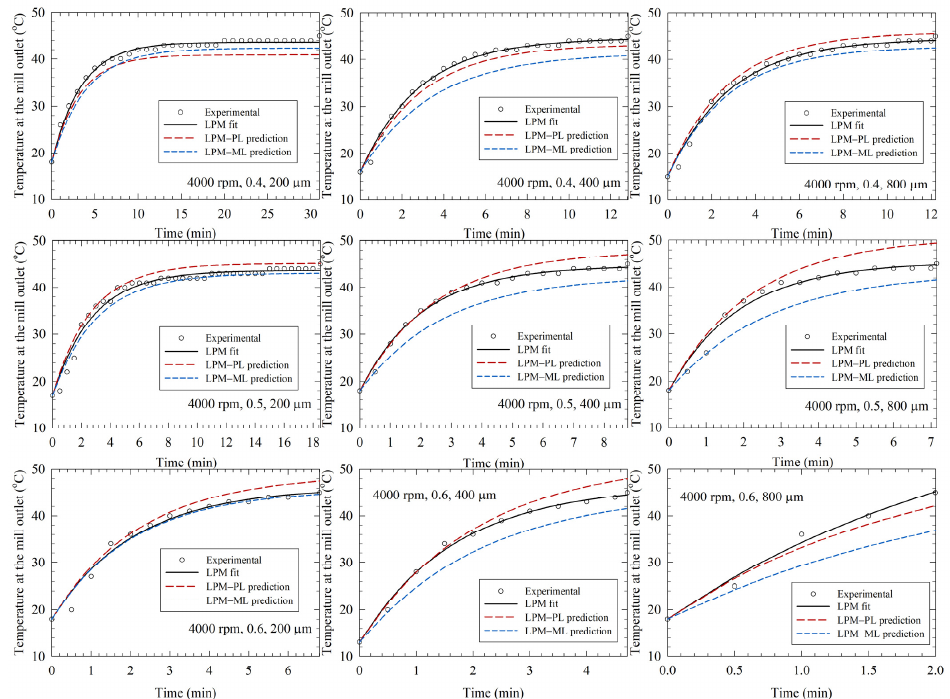
Figure 5. Experimental temperature profiles, direct fits by the lumped parameter model (LPM), and predictions by the LPM coupled with a power law (PL) model and a machine learning (ML) model. Left-to-right: increasing bead size, top-to-bottom: increasing bead loading, stirrer speed: 4000 rpm. To quantify the impact of the process parameters, motivated by our earlier work [33], a power-law (PL) model and machine learning (ML) model were trained using the directly fitted values of Q gen and UA in Runs 1–27, which were conducted at various stirrer speeds ω , bead loadings c , and the bead sizes D b . For the PL model training, Minitab was used, and Equations (4) and (5) were obtained via fitting.